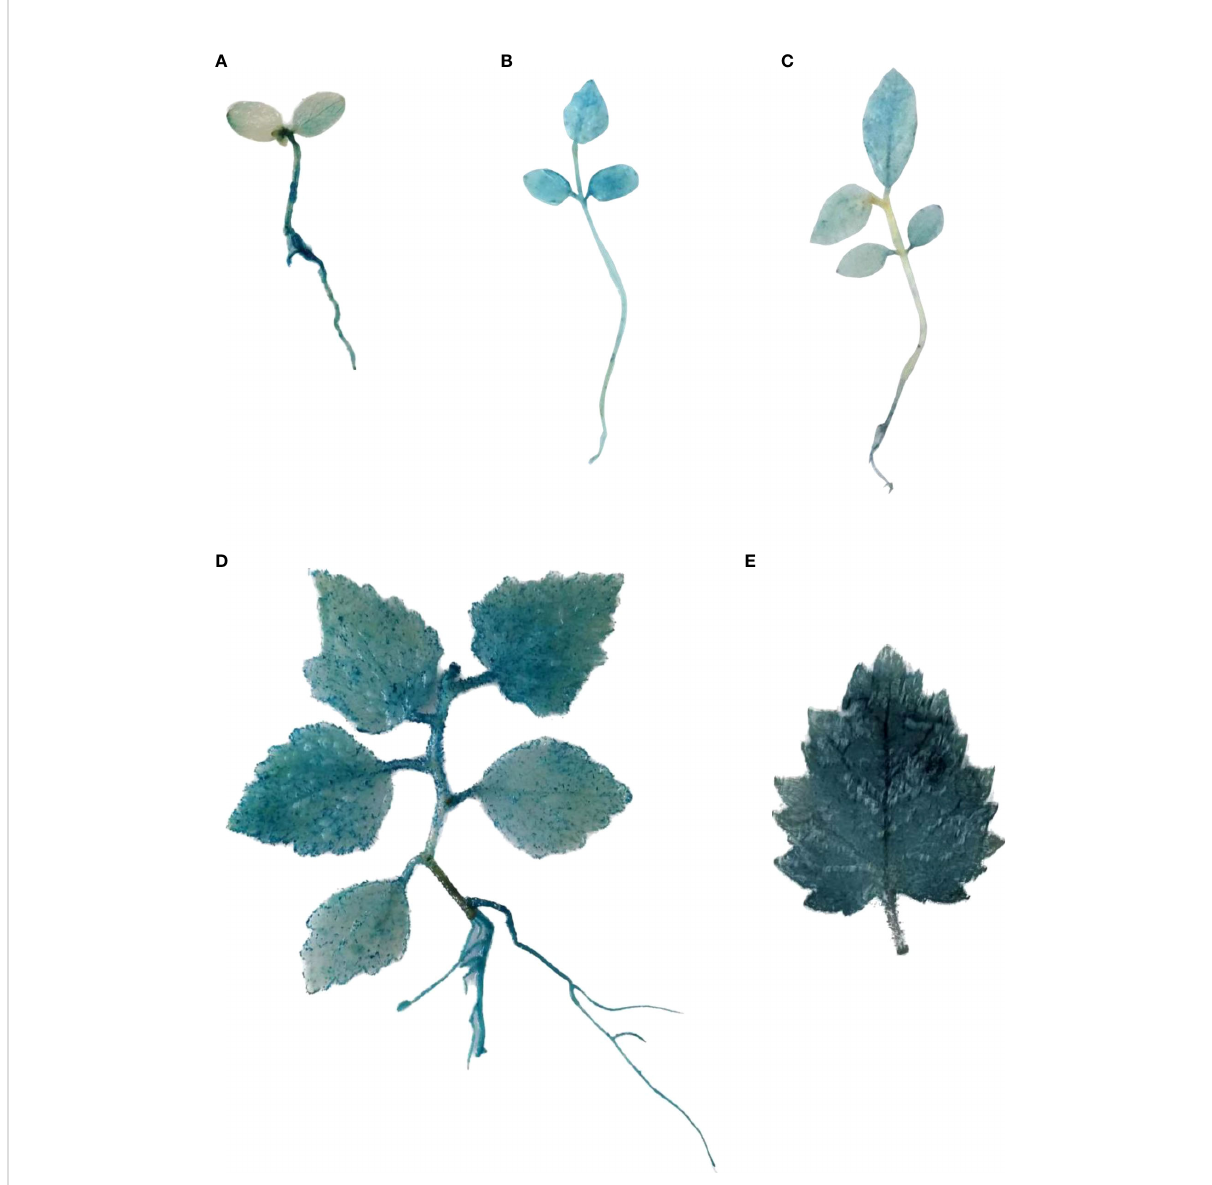
FIGURE 1 The temporal and spatial expression of BplMYB46 promoter in transient transgenic BplMYB46 promoter:: GUS birch plants. The BplMYB46 promoter:: GUS construct was transformed into birch plants and b -glucuronidase (GUS) histochemical staining was performed to investigate the temporal and spatial expression of BplMYB46 promoter. (A) 5-day-old seedling; (B) 10-day-old seedling; (C) 14-day-old seedling; (D) 30-day- old seedling; (E) mature leaf of 45-day-old